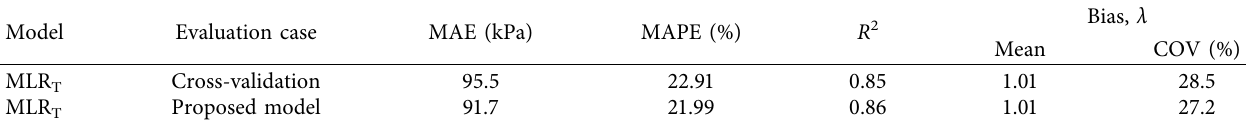
Figure 6: Comparison of observed and predicted ultimate bearing capacity of the proposed MLR model for approach Table 4: Prediction performance of the proposed model and it cross-validation (approach 1).